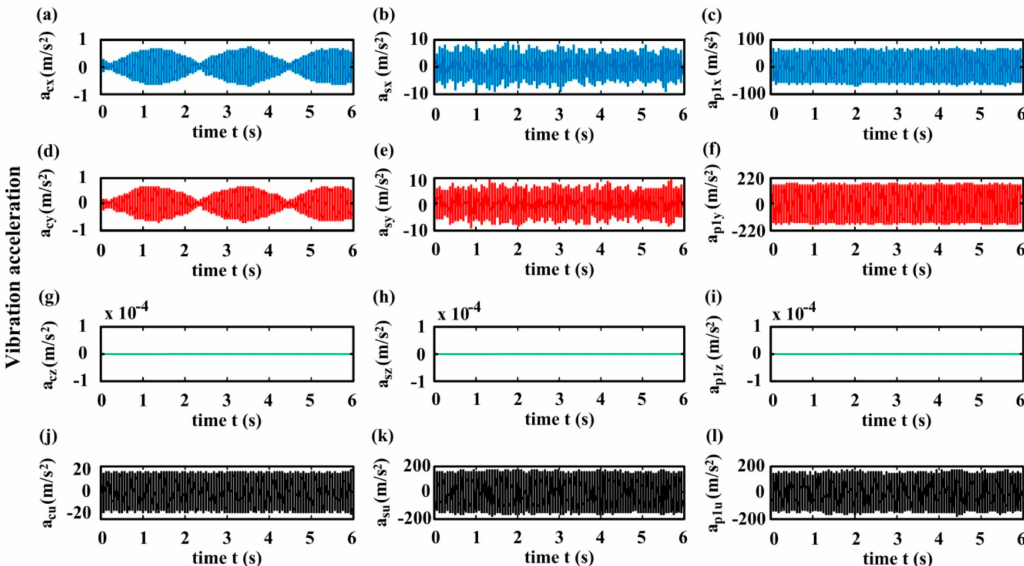
Figure 12. Variations of the vibration accelerations of the main members from the model in the absence of error excitations with gear mesh time. ( a , d , g , j ) the carrier accelerations in x -, y -, z -, and u -directions, expressed as a cx , a cy , a cz , and a cu , respectively; ( b , e , h , k ) the sun accelerations in x -, y -, z -, and u -directions, expressed as a sx , a sy , a sz , and a su , respectively; ( c , f , i , l ) the planet accelerations in x -, y -, z -, and u -directions, expressed as a p1x , a p1y , a p1z , and a p1u ,